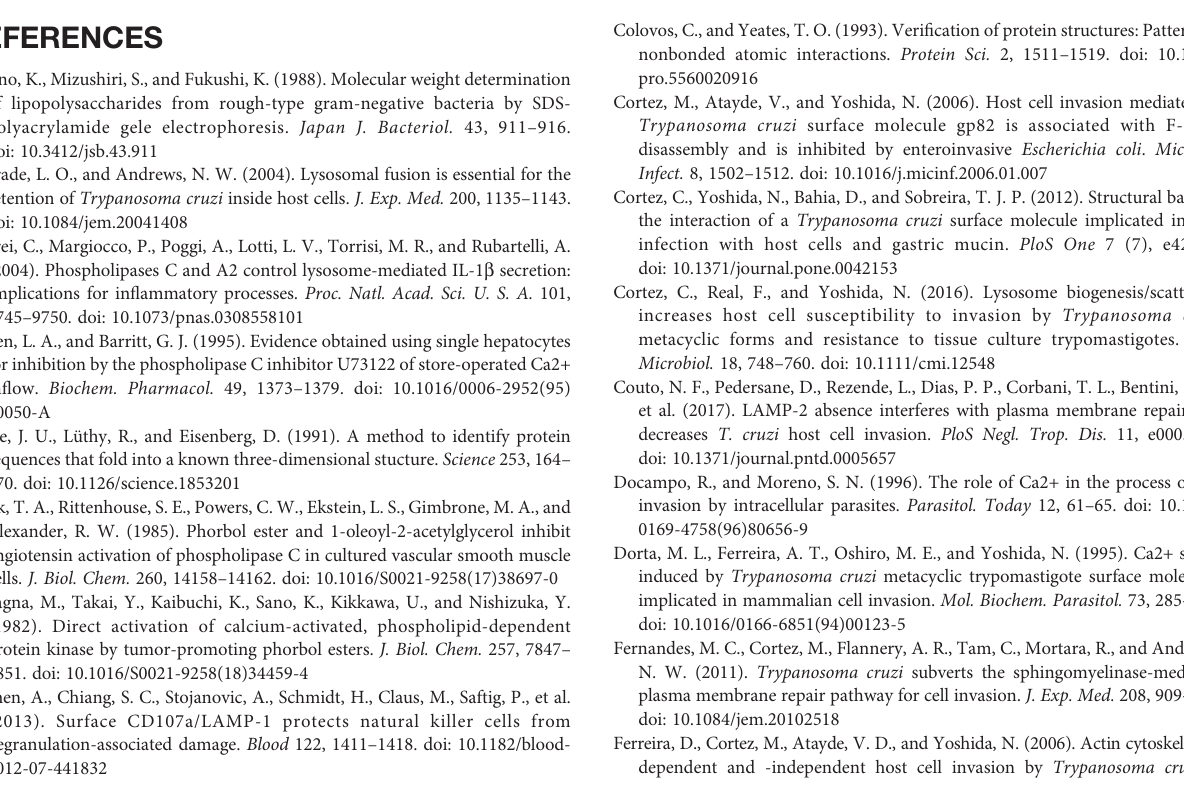
Supplementary Figure 1 | Lack of reactivity of puri fi ed r-gp82 with anti- E. coli antibody. Puri fi ed r-gp82 and E. coli extract were analyzed by western blotting, using monoclonal antibody to gp82 and anti- E. coli antiserum. Note in the r-gp82 preparation the band detectable by monoclonal antibody to gp82, but no bands corresponding to bacterial components recognized by anti- E. coli antiserum. Supplementary Figure 2 | Host cell invasion by T. cruzi MT. (A) HeLa cells were incubated with MT for 1 h and then stained with Giemsa for internalized parasite counting. Values are the means ± SD of fi ve independent assays performed in duplicate. Shown in (B) is a cell harboring one parasite (arrow), surrounded by non- infected cells. Adherent parasites are also seen. Shown in (C) are cells harboring one parasite and a binucleated cell with four internalized parasites (arrows). Scale bar = 10 µm. Supplementary Figure 3 | Lysosome-dependent T. cruzi MT internalization. HeLa cells were incubated with MT for 30 min and then processed for confocal fl uorescence microscopy to visualize lysosomes (green), nucleus (blue), and non- internalized parasites (red). Scale bar = 10 µm. Note the internalized MT with lysosome marker (white arrows) and lysosome accumulation at the cell edges (yellow arrows) in binucleated large cells. Supplementary Figure 4 | Relative positioning of lysosomes upon incubation of cells with r-gp82. HeLa cells treated or not with r-gp82 ( Figure 3B ) were analyzed by plotting green pixels (lysosomes) and blue pixels (nucleus) in a histogram. The lysosomes positioned away from the nucleus were then plotted in a histogram. The peak signal intensity in the presence of r-gp82 is indicated by red arrow. Supplementary Figure 5 | PKC activation induced by gp82-mediated interaction of MT with host cells. The parasites were incubated in absence or in the presence anti-gp82 monoclonal antibody for 30 min and then were seeded onto HeLa cells. After 30 min incubation, the cells that interacted with MT and the control cells that had no contact with parasites were processed for detection of phosphorylated